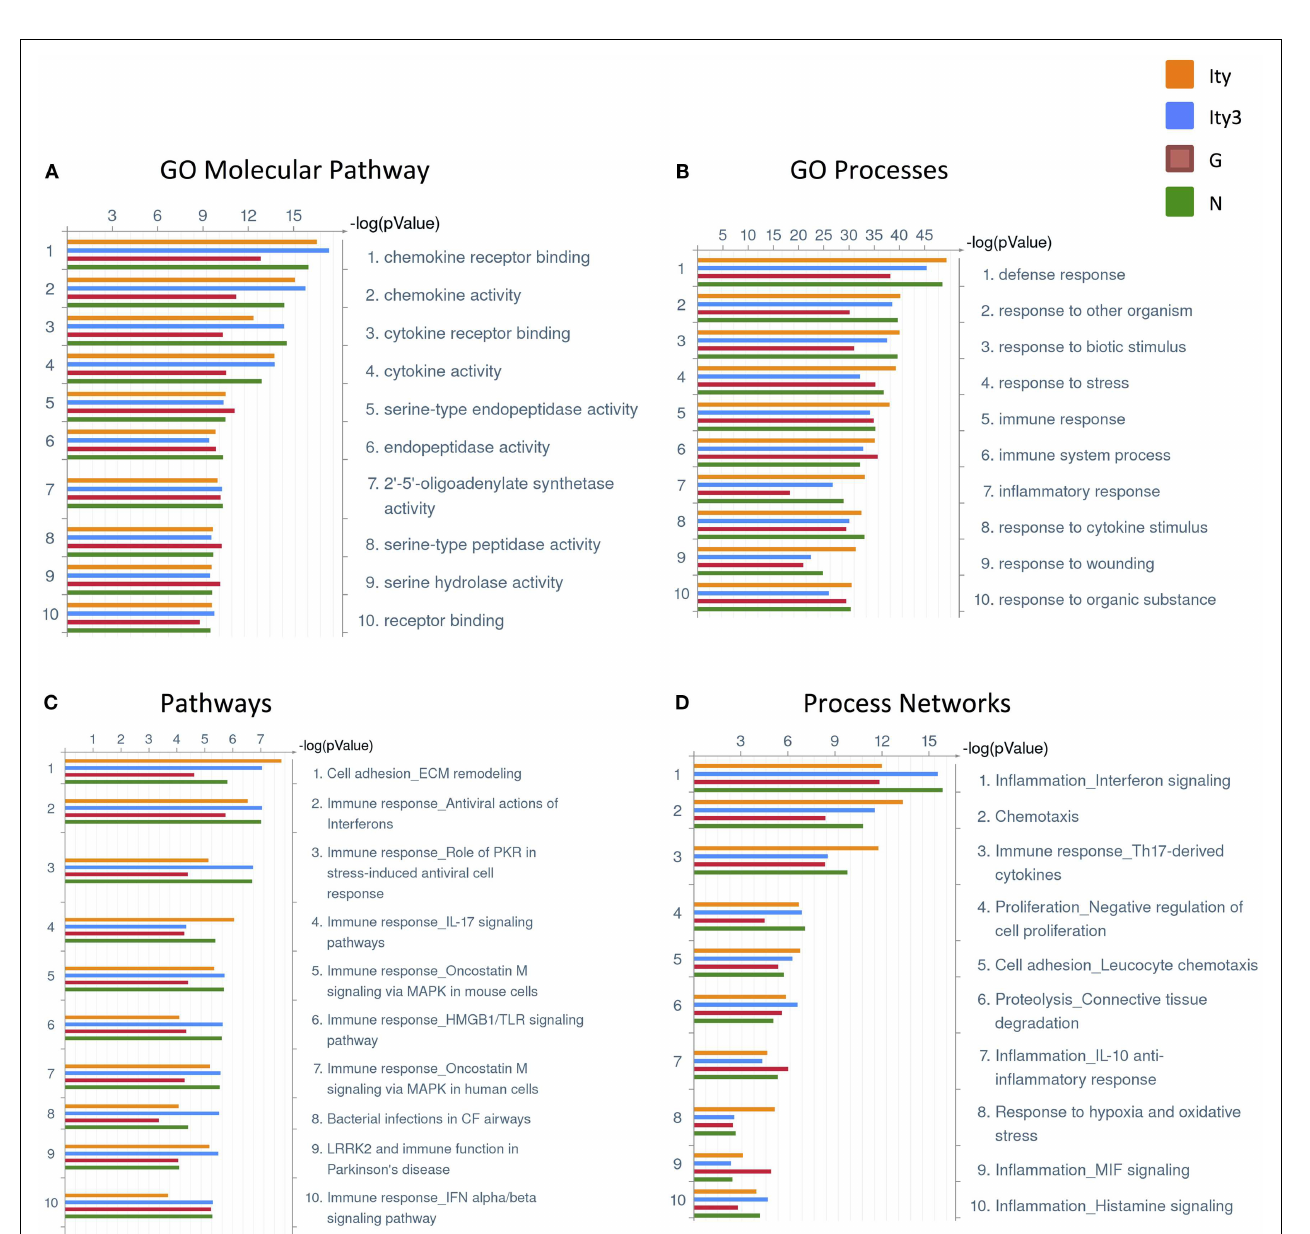
strains.The sub-congenic strain Ity3.RecG shows a lower − log( p -value) for chemokine and cytokine receptor activity within the GO molecular pathways as well as lower − log( p -values) for response to bacteria in the GO processes. This is consistent with previous data suggesting that the Ity3.RecG mice have a diminished inflammatory response following infection compared to parental strains